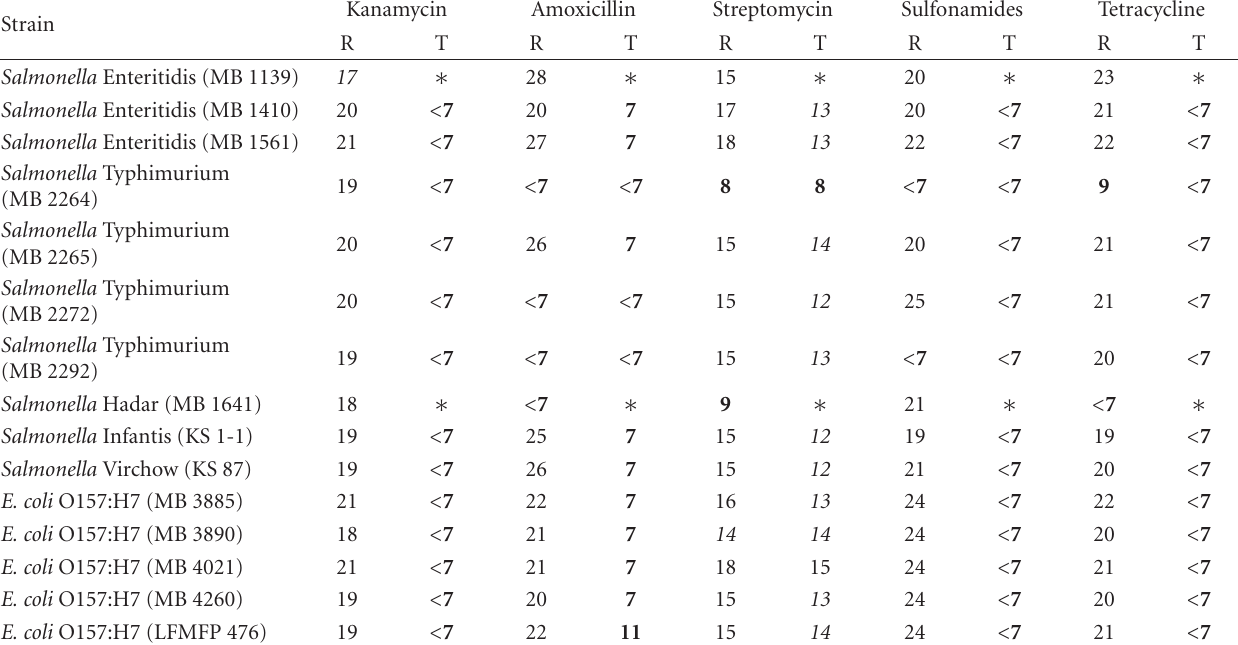
Table 2: Inhibition zone diameters (mm) of the recipients (R) and the transconjugants (T).